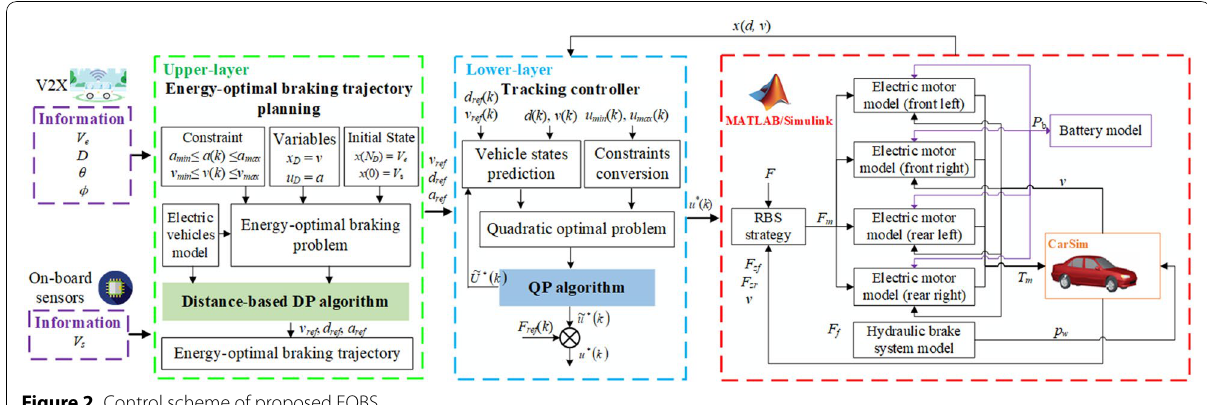
Figure 2 Control scheme of proposed EOBS